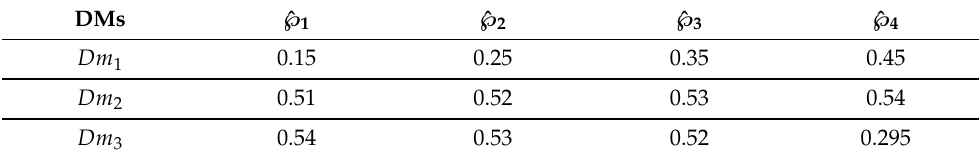
Table 3. Matrix formation of FPCIFHSS ˆ Θ ˆ Λ